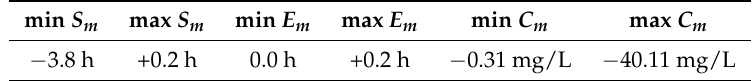
Table 2. Net3 network minimum and maximum errors ( S m , E m and C m ) for 30